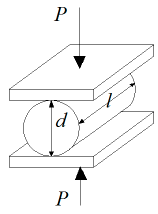
Figure 4. Diagram of diametric compression test loading.